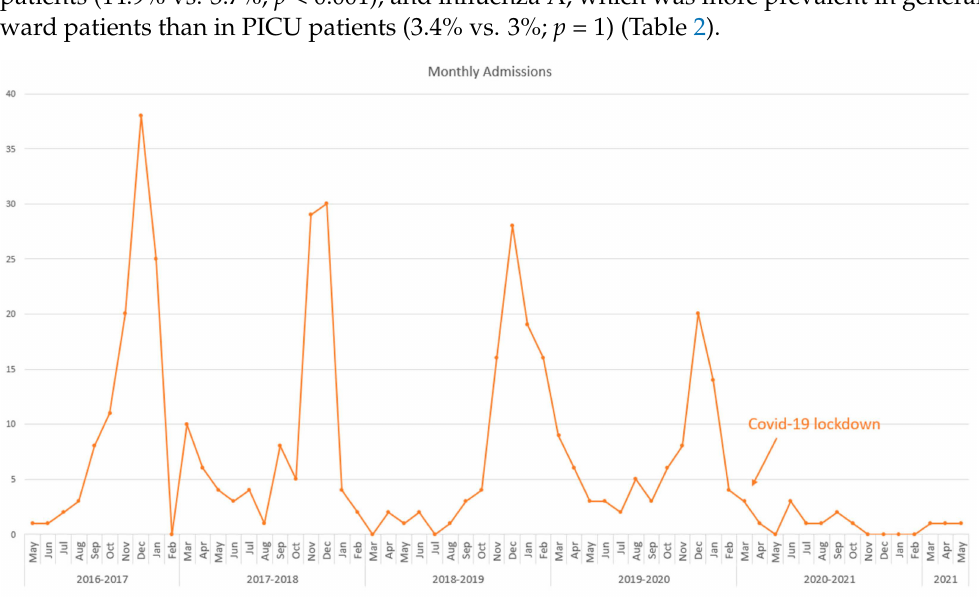
Figure 1. Admission numbers among bronchiolitis patients showed a seasonal pattern, with a spike in cases between September and March. However, during the coronavirus disease 2019 lockdown in March 2020, a remarkable decrease in admission was observed. Table 2. Causative agents of viral bronchiolitis in patients admitted to the general ward or